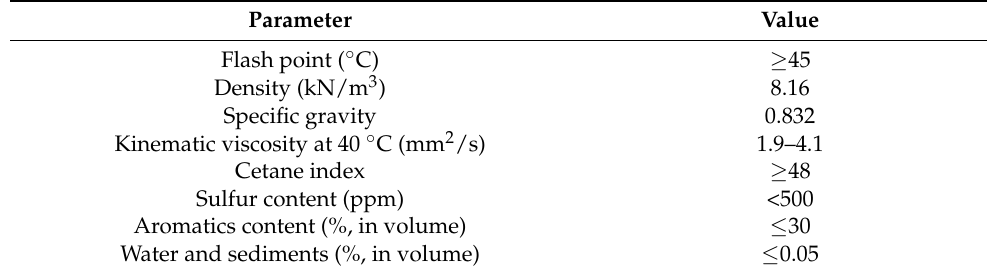
Table 1. Applied diesel fuel specifications